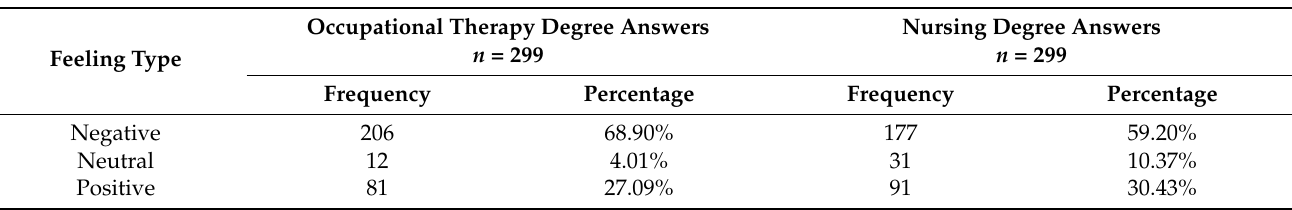
Table 7. Percentages of feelings (positive, negative and neutral) in the answers to the open questions of the Survey of Satisfaction with the Gamification Activities